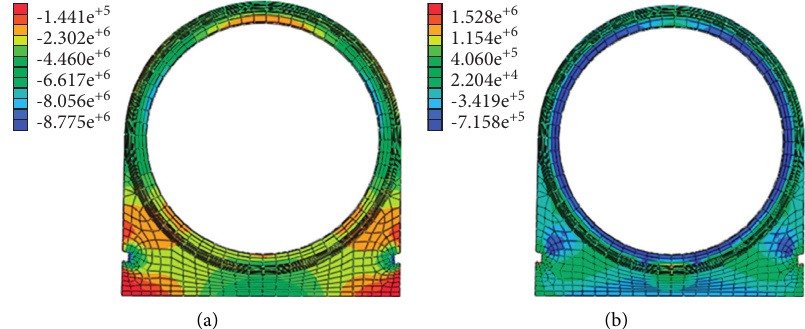
Figure 18: Stress cloud diagram of the prestressed culvert structure: (a) maximum principal stress; (b) minimum principal